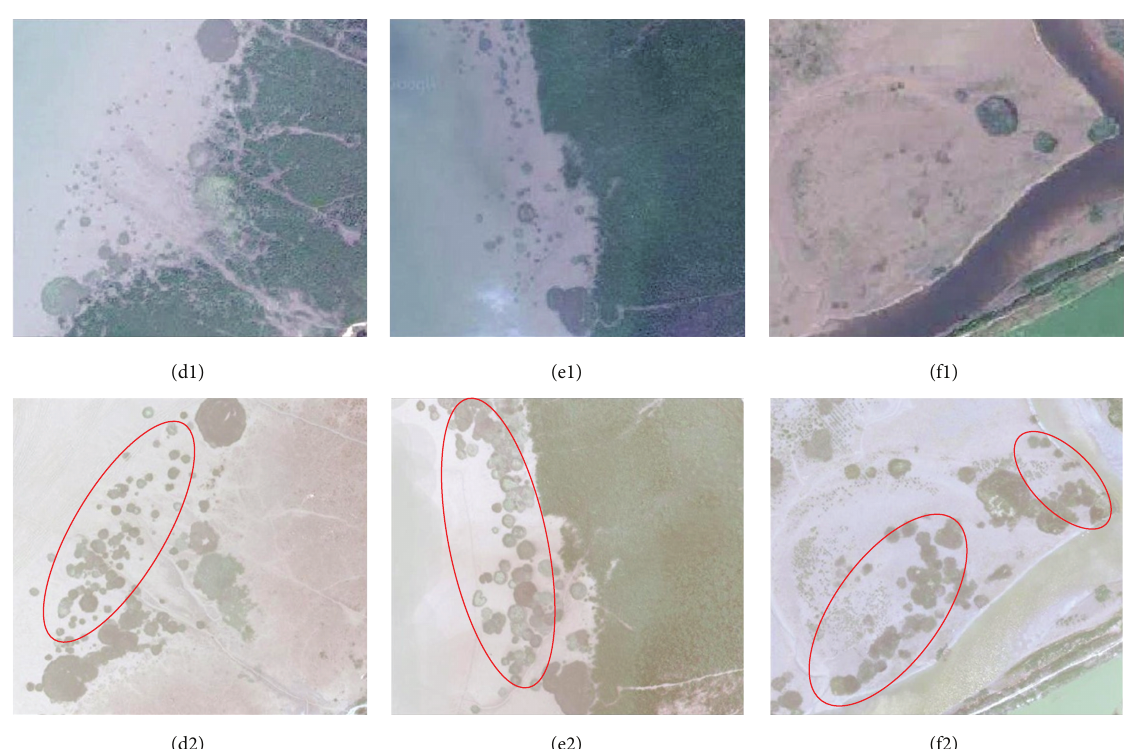
Figure 5: (d1)–(f1) are maps obtained from Google Earth in 2009 of the three regions of northwest of Dandou Sea, southeast of Dandou Sea and Shatian port. (d2)–(f2) are the same regions corresponding to (d1)–(f1) obtained from the UVA imagery with the expanded S. alterniflora denoted by red